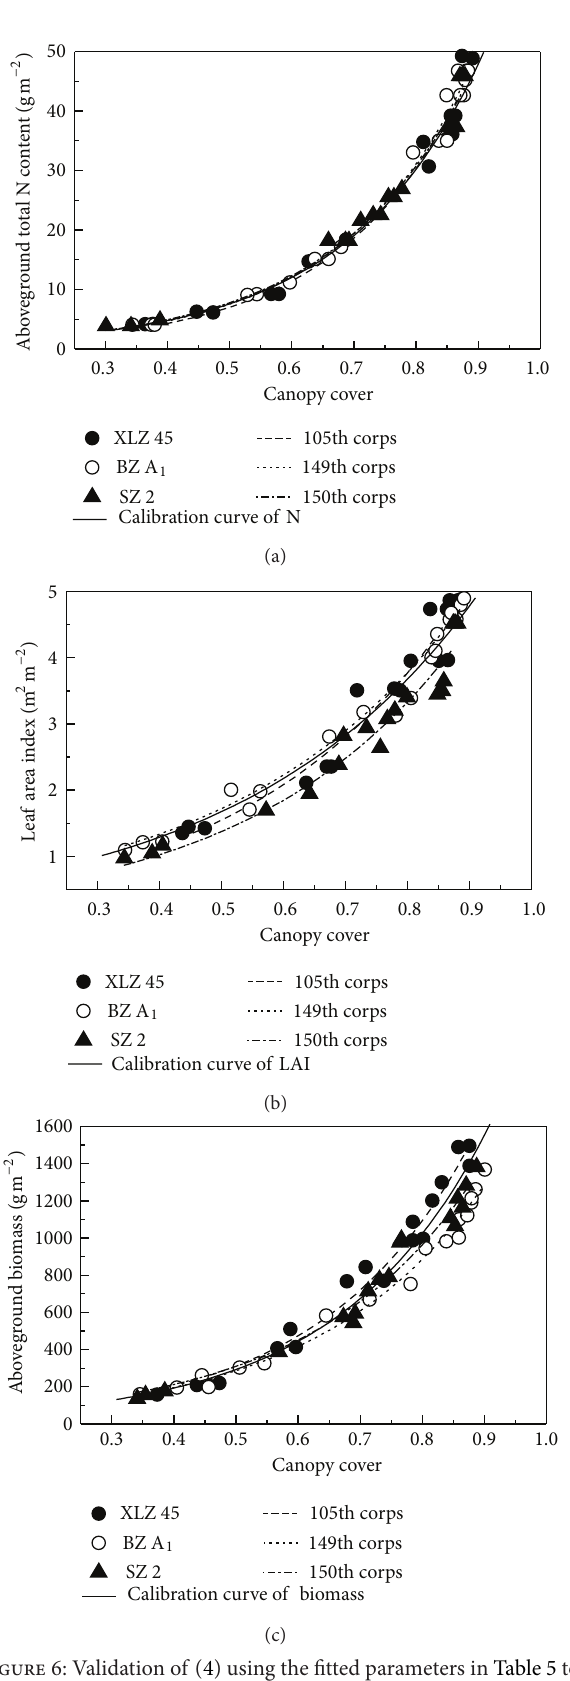
Figure 6: Validation of (4) using the fitted parameters in Table 5 to predict aboveground total N content, LAI, or aboveground biomass in three cotton fields in experiment